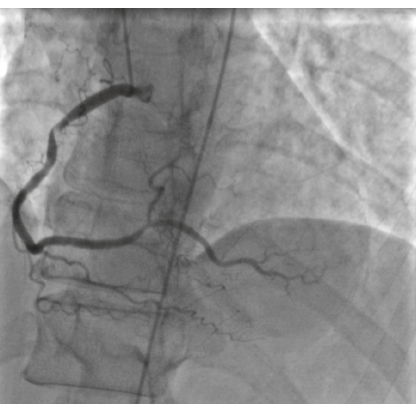
Figure 1: Left heart catheterization identifying stenosis of proximal right coronary artery.